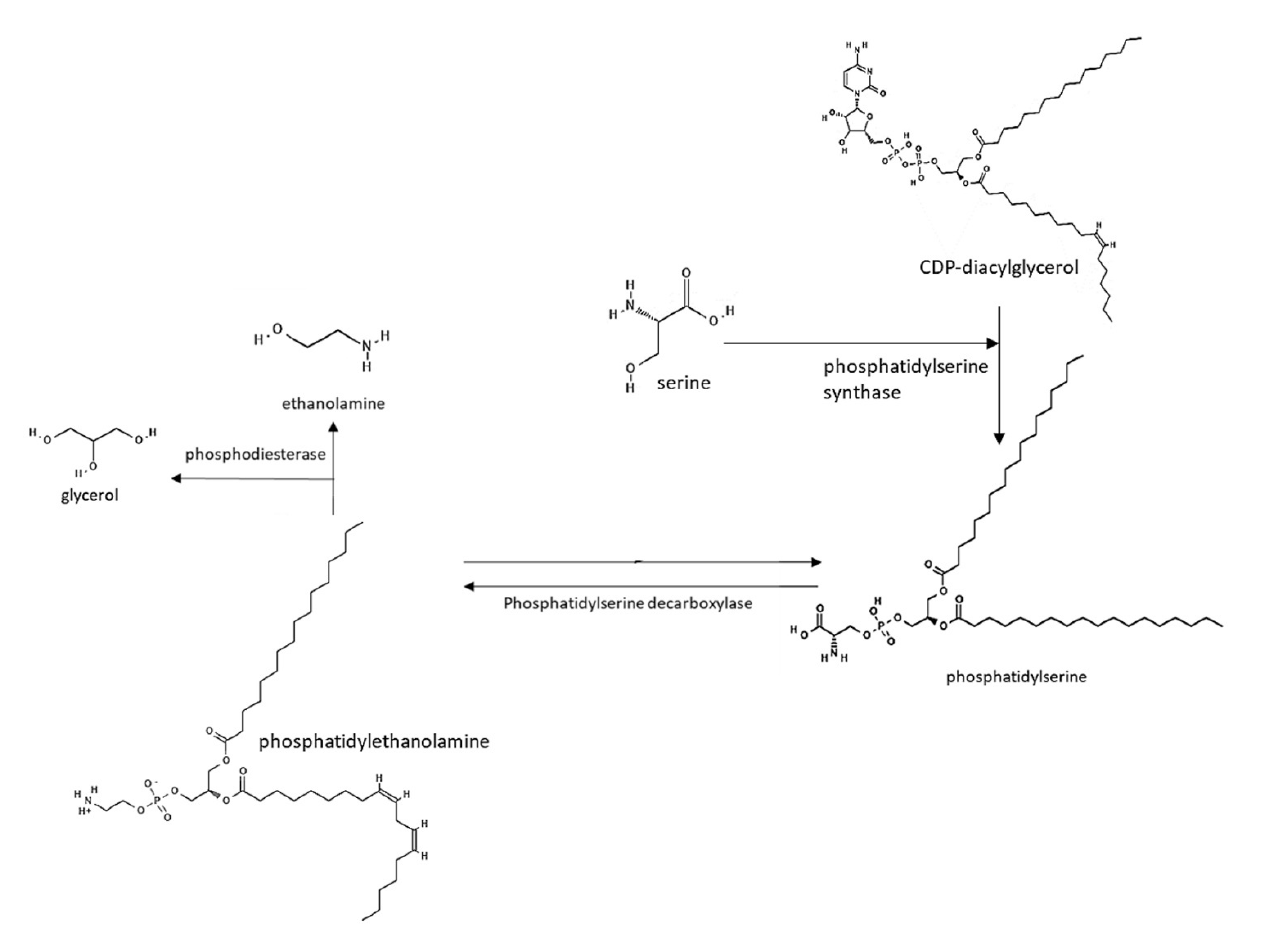
Figure 4. Combined schematic model of ethanolamine and phosphatidylethanolamine biosynthesis in bacteria [229,232,240]. Biosynthetic reactions with the respective substrates, products, and involved enzymes are shown. The bacteria indirectly biosynthesise of ethanolamine from serine via the phosphatidylserine synthase and the phosphatidylserine decarboxylase is depicted. CDP: cytidine diphosphate.